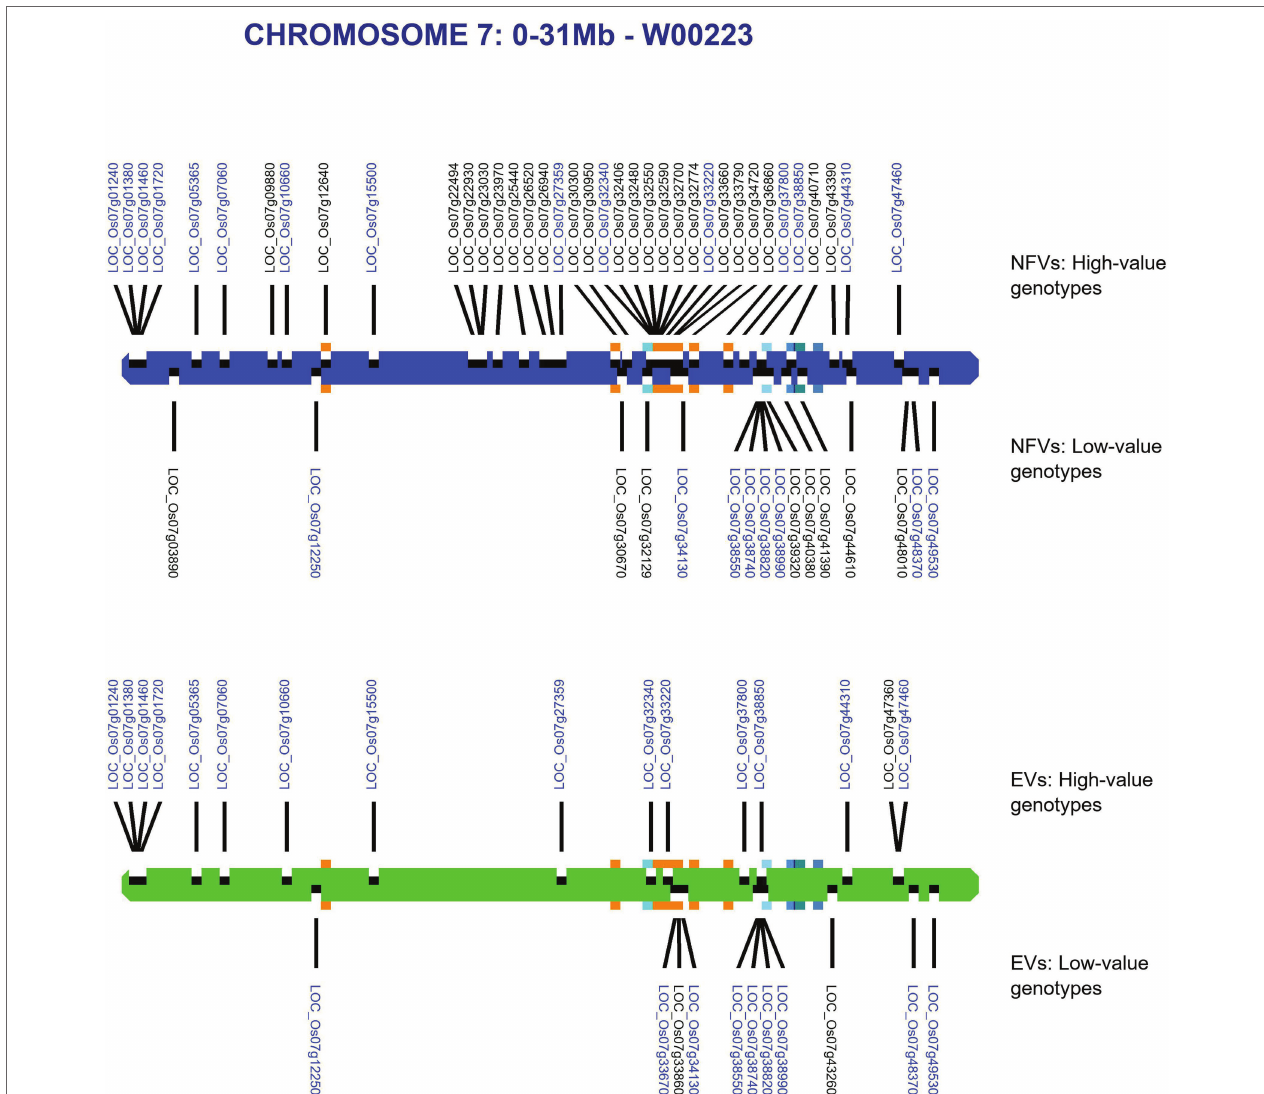
FIGURE 6 | Map of chromosome 7 (0–31.0 Mb) showing all identified LGHs across elite cultivar accessions and LGHs identified on Thai landrace Ai-Tai (W00223). Orange square markers show LGHs found on the landrace accession Ai-Tai, while gene positions for known grain length genes LOC_Os07g32170 ,